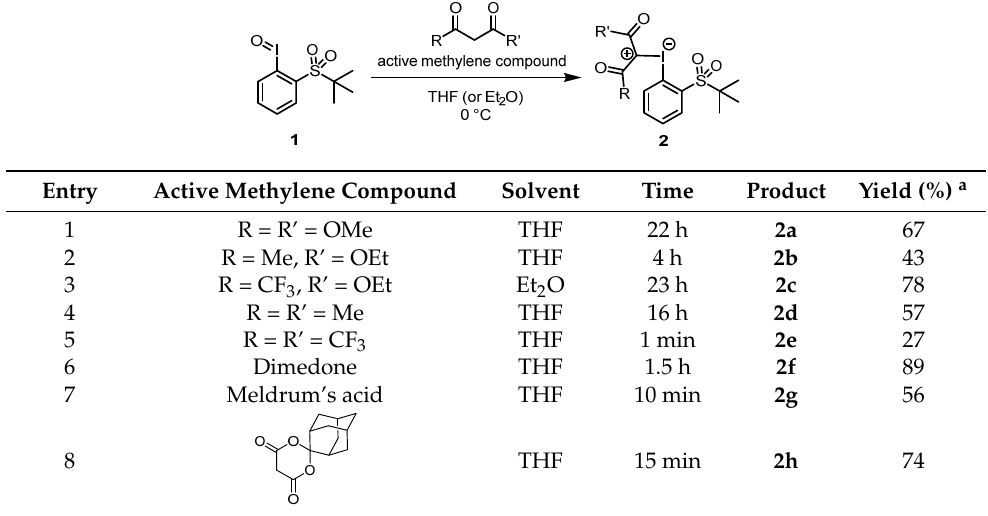
Table 1. Synthesis of various iodonium ylides that bear an ortho - t -BuSO 2 group on the aromatic ring ( 2 ) from iodosobenzene 1 .